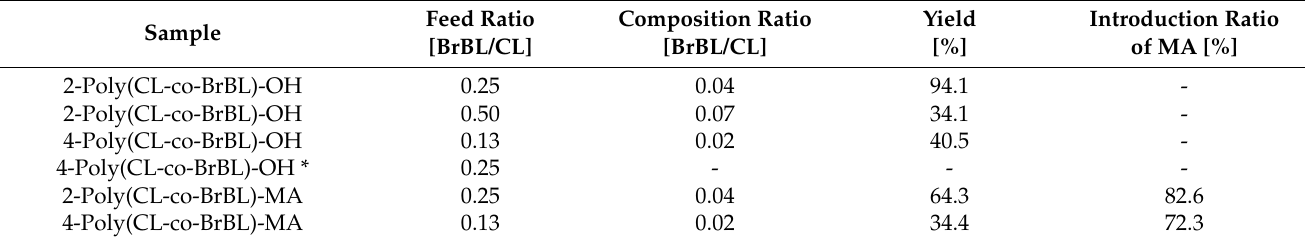
Table 1. Preparation of branched copolymers and macromonomers comprising CL and BrBL.